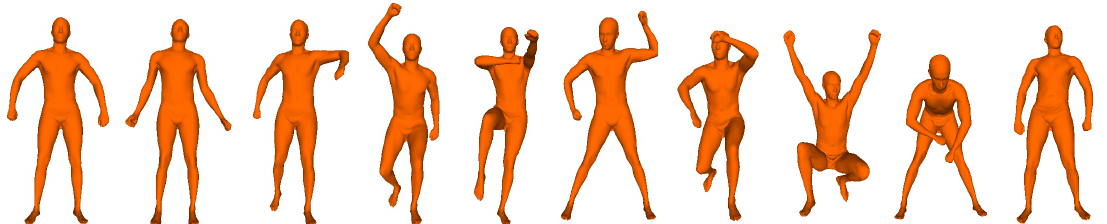
Figure 6. The ten human poses of a subject in the SHREC-RE dataset